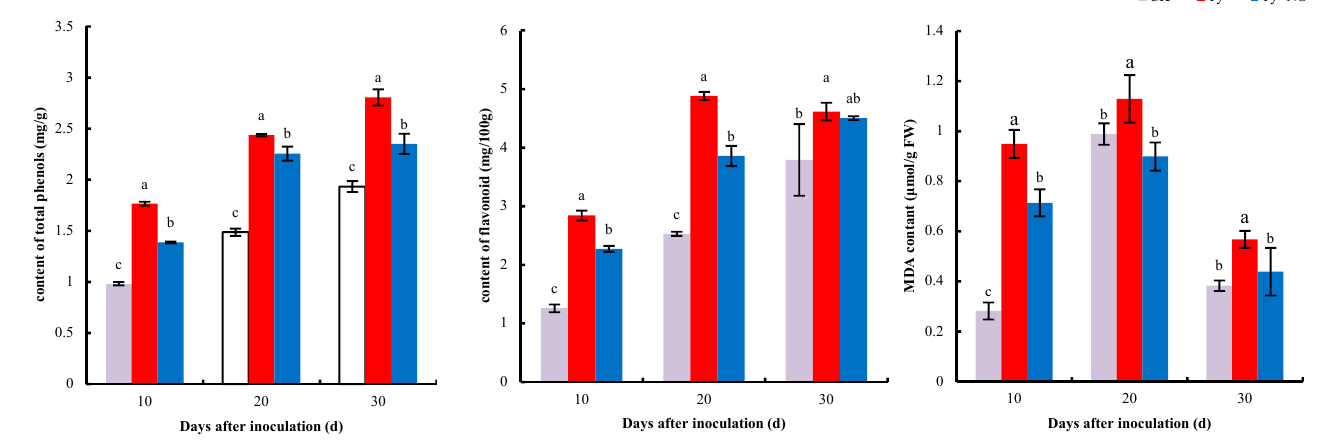
Figure 10. Regulation of total phenols, flavonoids, and MDA content in diseased plants by exogenous NO. Different lowercase letters indicate significant differences between treatments, p < 0.05. Same